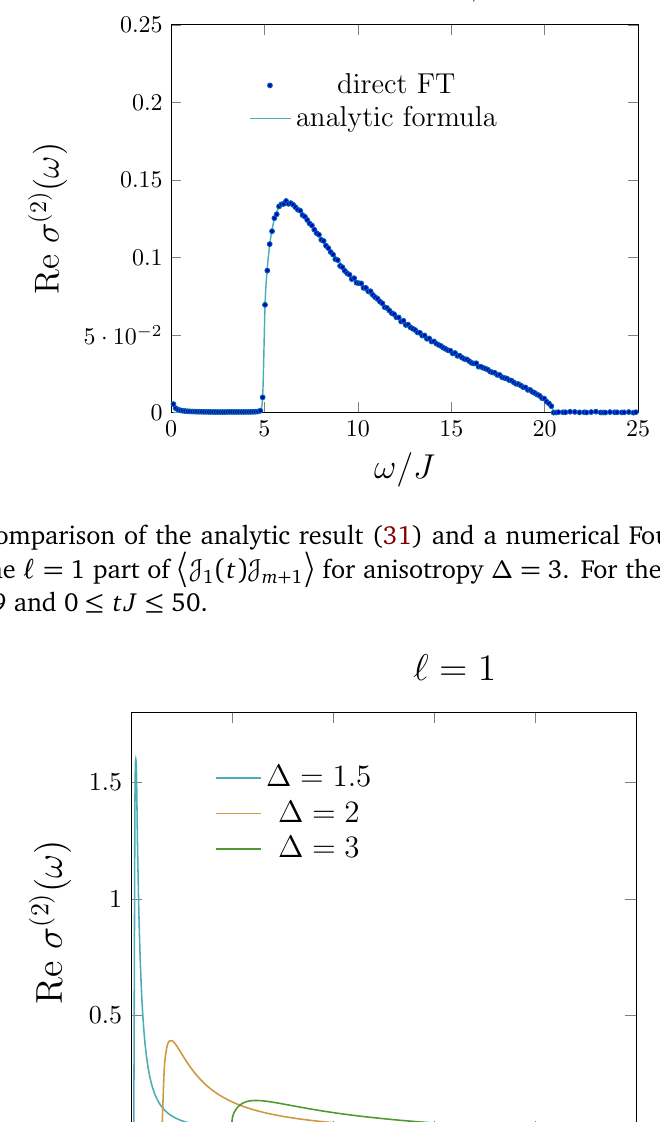
Figure 5: (cid:96) = 1 contribution, Eq. (31), to Re σ ( 2 ) ( ω ) for various ∆